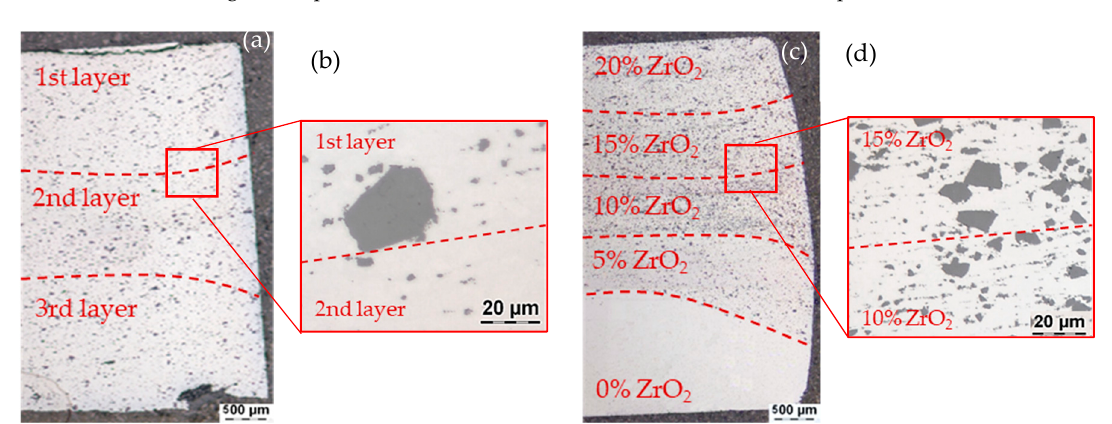
Figure 7. Specimens obtained after subjecting pre-sintered specimens to the forming process: ( a ) overview of homogenous specimen with 10% ZrO 2 , ( b ) boundary between two layers with ZrO 2 content of 10%, ( c ) overview of graded specimen, and ( d ) boundary between layers with ZrO 2 contents of 10% and 15%.